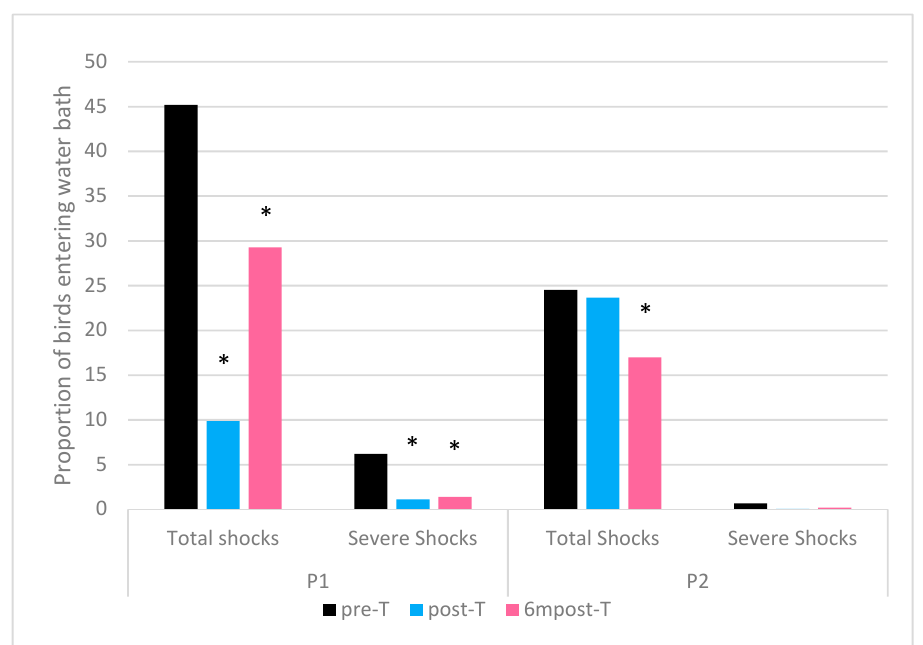
Figure 4. Proportion of birds receiving a pre-stun shock (score PSS1 and PSS2 combined) and severe pre-stun shocks (score PSS2) in both plants across each visit. * represents a statistically significant difference in proportion from pre-training visit ( p ≤ 0.05) calculated using the exact Chi-squared test.